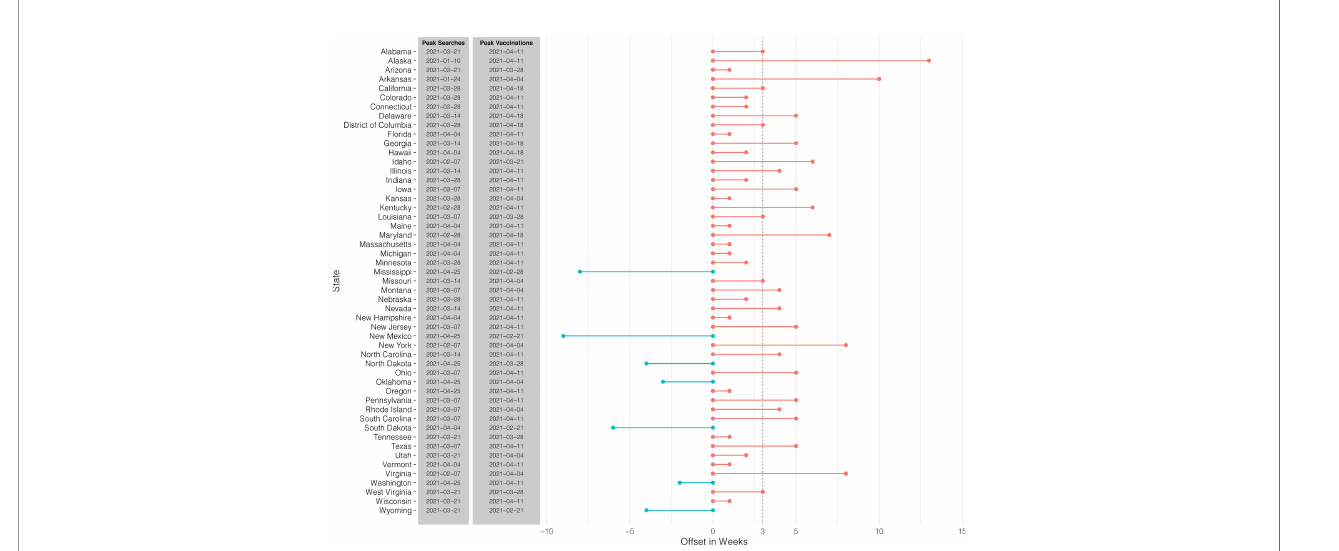
FIGURE 4 | Offsets between peaks in COVID-19 vaccination online searches and vaccination rates across 51 US states. Temporal peaks of online searches for COVID-19 vaccinations between June 1, 2020 and May 31, 2021, as well as for COVID-19 vaccination rates between December 20, 2020 - May 31, 2021, across 51 US states are shown. Offsets in weeks between peaks in online searches and vaccination rates are depicted as bar graphs. The dotted line indicates the median of offsets across all shown US